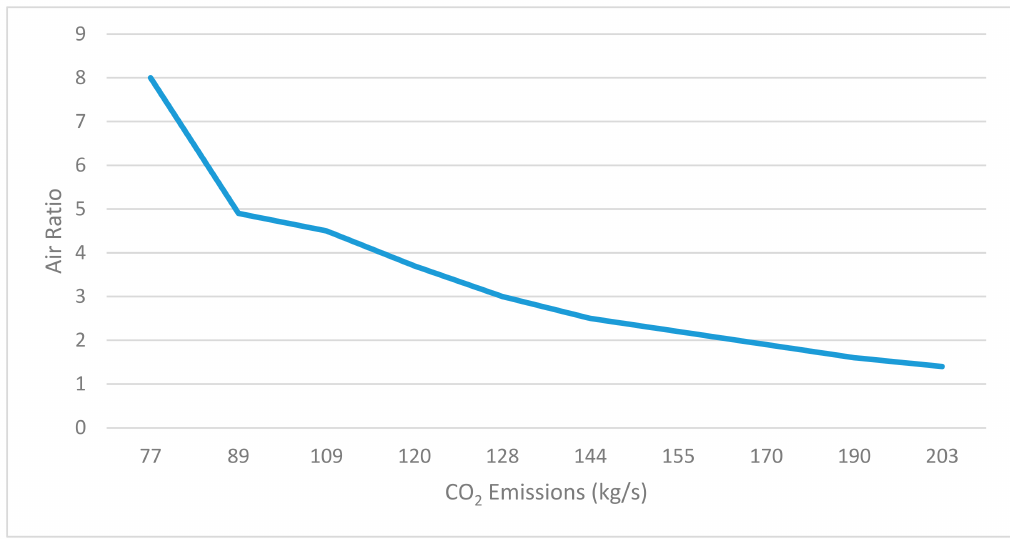
Figure 6. Air ratio and CO 2